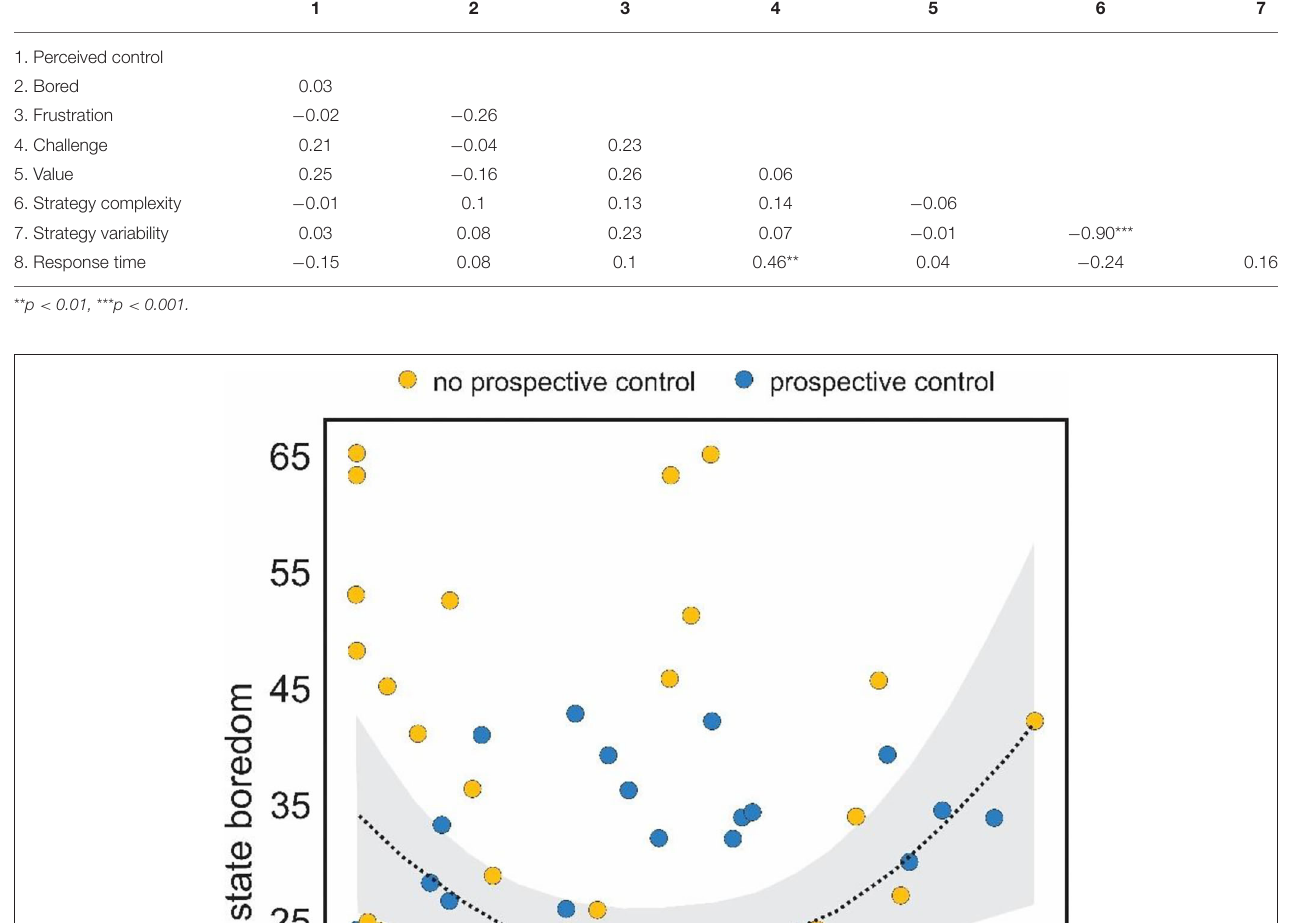
TABLE 5C | Zero-order correlations of all study variables and their significance levels (Study 2: No-Prospect Control). 1 2 3